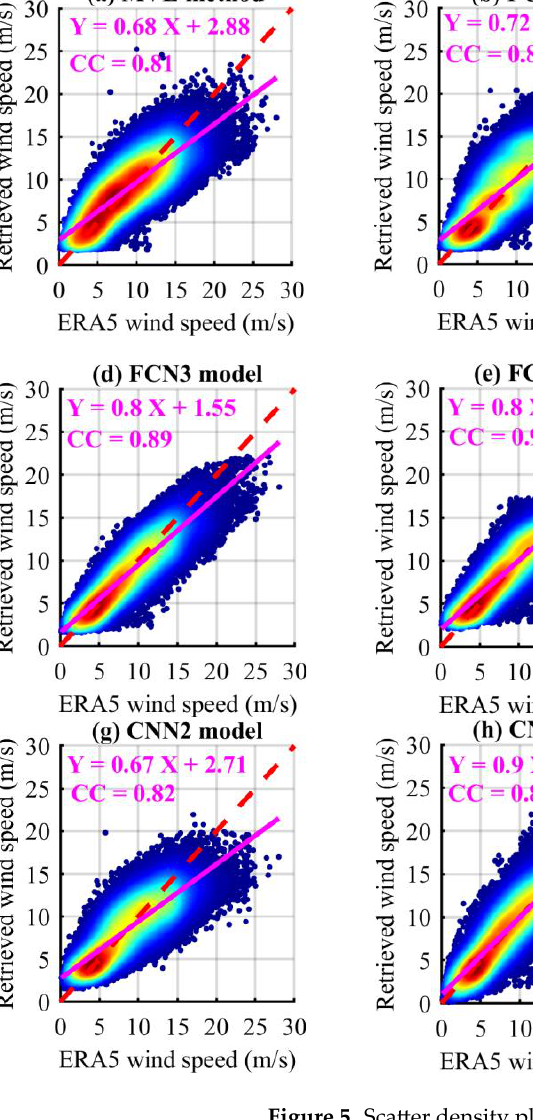
Figure 6. When ERA5 wind speed is used as reference for ( a ) RMSE and ( b ) MAE for different wind speed ranges. In order to compare the global performance of wind speed retrieved by GloWS-Net and the traditional model, we selected the period from July to August 2021 in the test data set for analysis. Figure 7 shows the ERA5 wind speed and the results retrieved using the